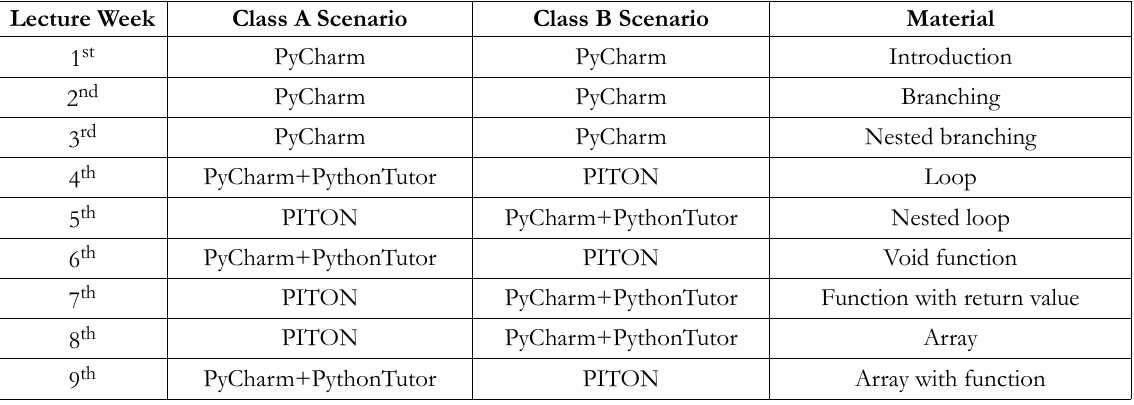
Table 1. Scenario distribution per